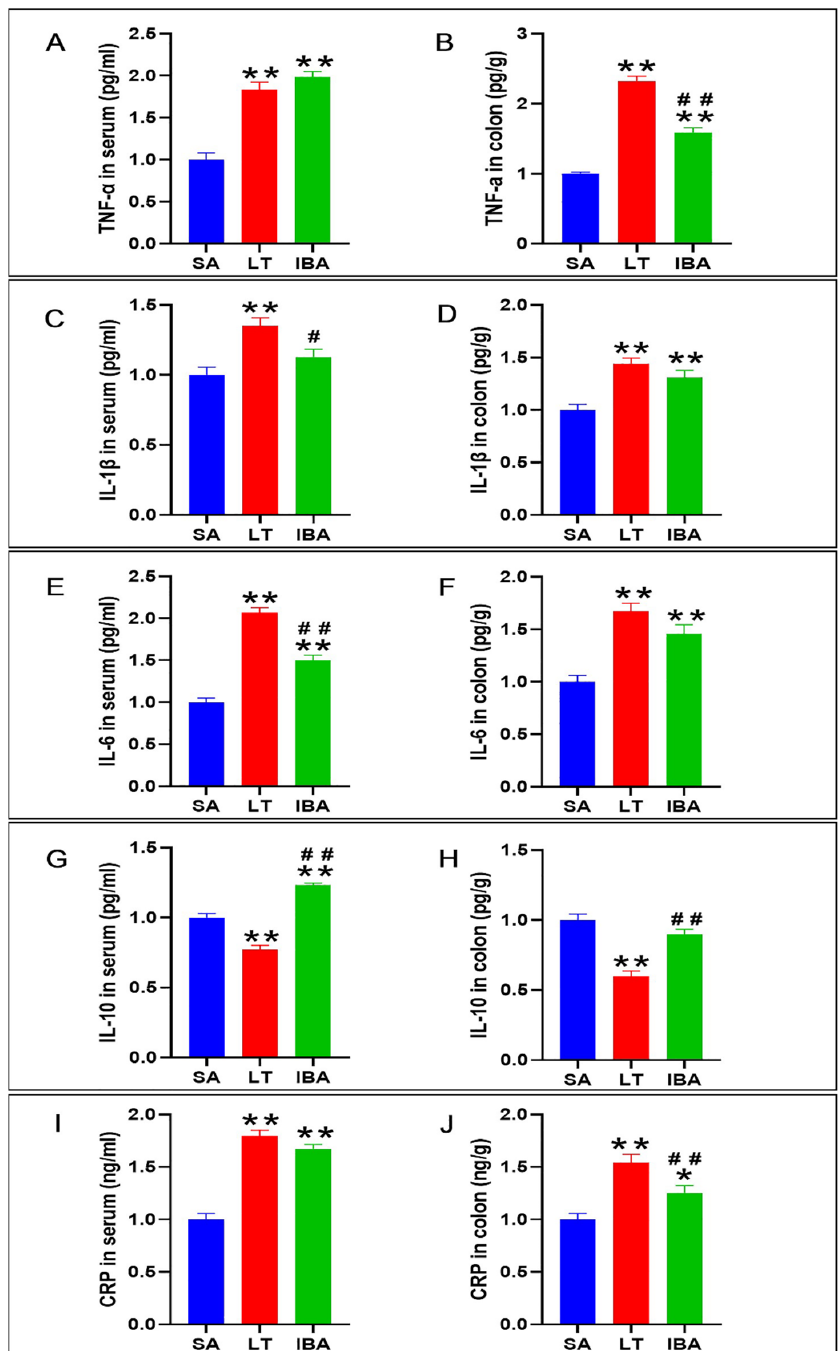
Figure 11. Detection of inflammatory factors in serum and colon of Daurian ground squirrels. ( A ) The concentrations of TNF- α (tumor necrosis factor- α ) in serum. ( B ) The concentrations of TNF- α in colon tissue. ( C ) The concentrations of IL-1 β (interleukin-1 β ) in serum. ( D ) The concentrations of IL-1 β in colon tissue. ( E ) The concentrations of IL-6 (interleukin-6) in serum. ( F ) The concentrations of IL-6 in colon tissue. ( G ) The concentrations of IL-10 (interleukin-10) in serum. ( H ) The concentrations of IL-10 in colon tissue. ( I ) The concentrations of CRP (C-reactive protein) in serum. ( J ) The concentrations of CRP in colon tissue. SA, summer active; LT, late torpor; IBA, interbout arousal. Mean ± SEM. n = 6. Compared with SA group, * p < 0.05, ** p < 0.01. Compared with the LT group, # p < 0.05, ## p < 0.01.